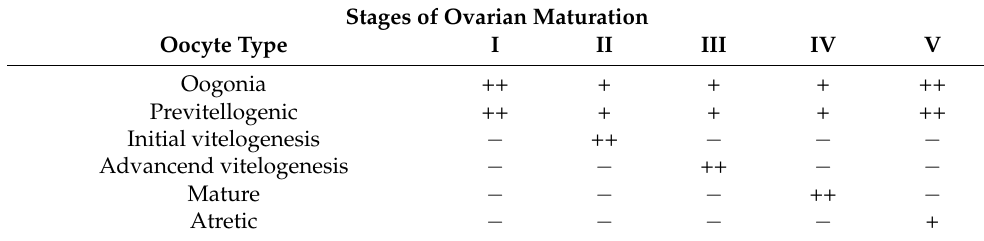
Table 1. Cell composition present in ovarian of P. schmmitt . Stages of Ovarian